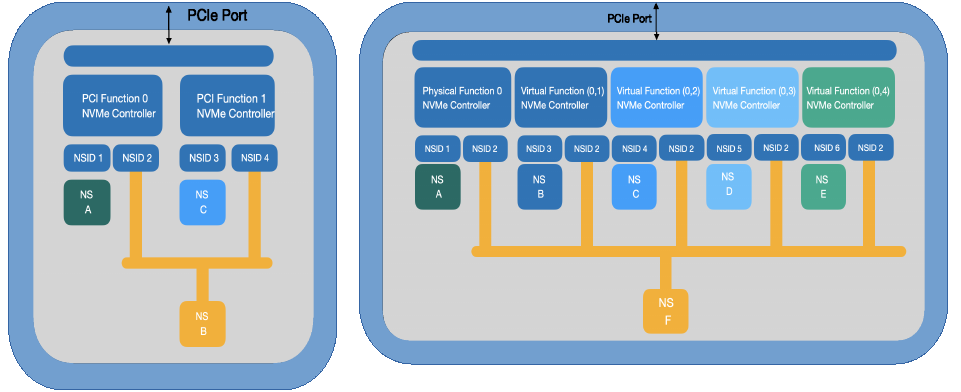
Figure 6. NVMe topology in PCI Express [23].